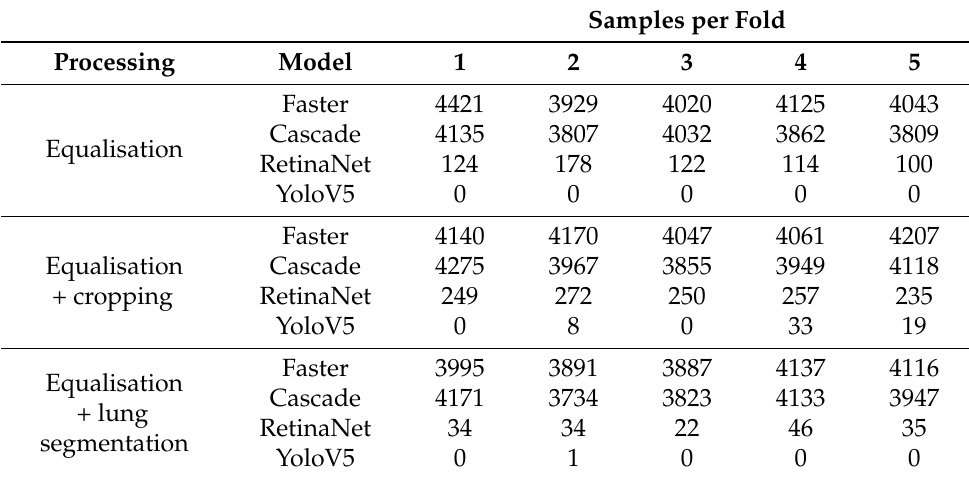
Table 4. Number of samples with detected bounding boxes (pseudo-labels) per fold on the HM Hospitales data set.